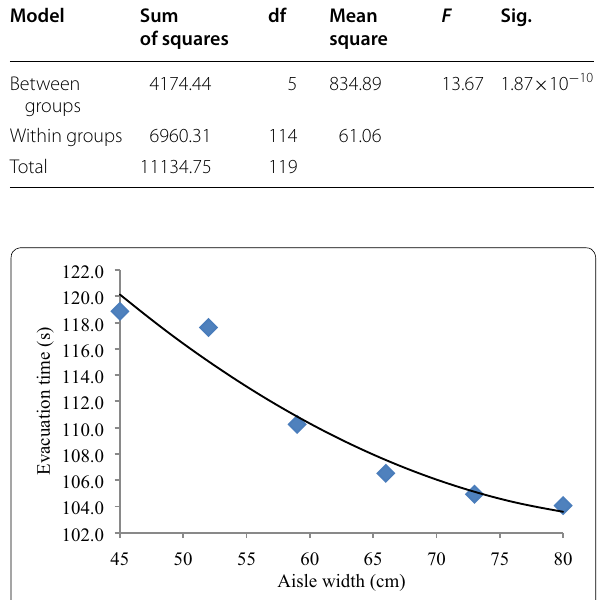
Figure 9 Fitting curve of the evacuation time and aisle